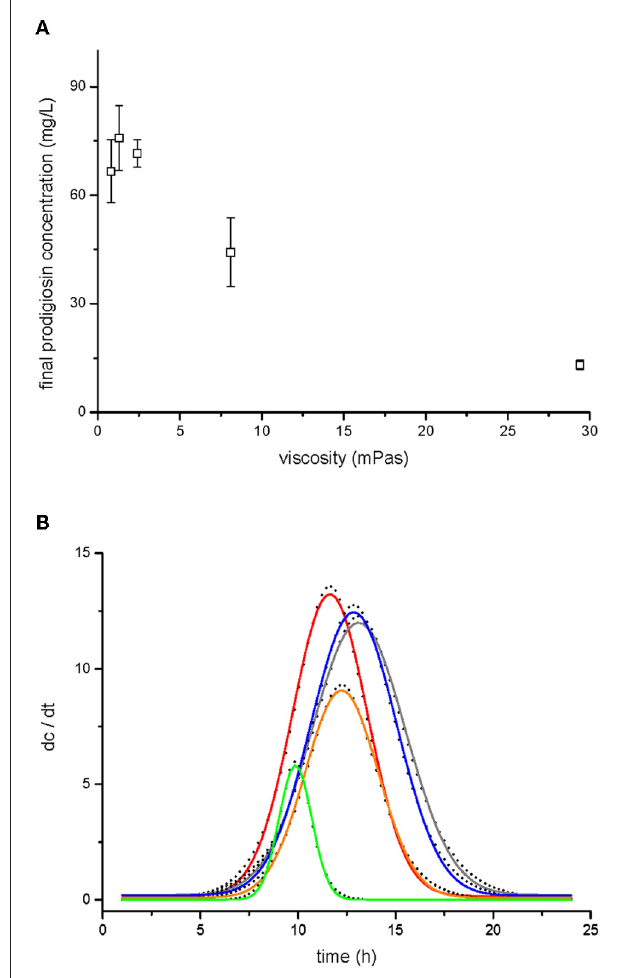
FIGURE 4 | Prodigiosin production by V. ruber at different viscosities. Prodigiosin concentration after 24h of bacterial growth is shown in panel (A) . The values presented are means and standard deviations ( n = 3). Dynamics of prodigiosin production are presented in panel (B) . The dots represent the first derivative of prodigiosin concentration (dc/dt) and were fitted with Gaussian distribution (lines). The data presented are means of three pigment concentrations at each time of extraction. Legend: red line–0.8mPas, gray line–1.3mPas, blue line–2.4mPas, orange line–8.1mPas, green